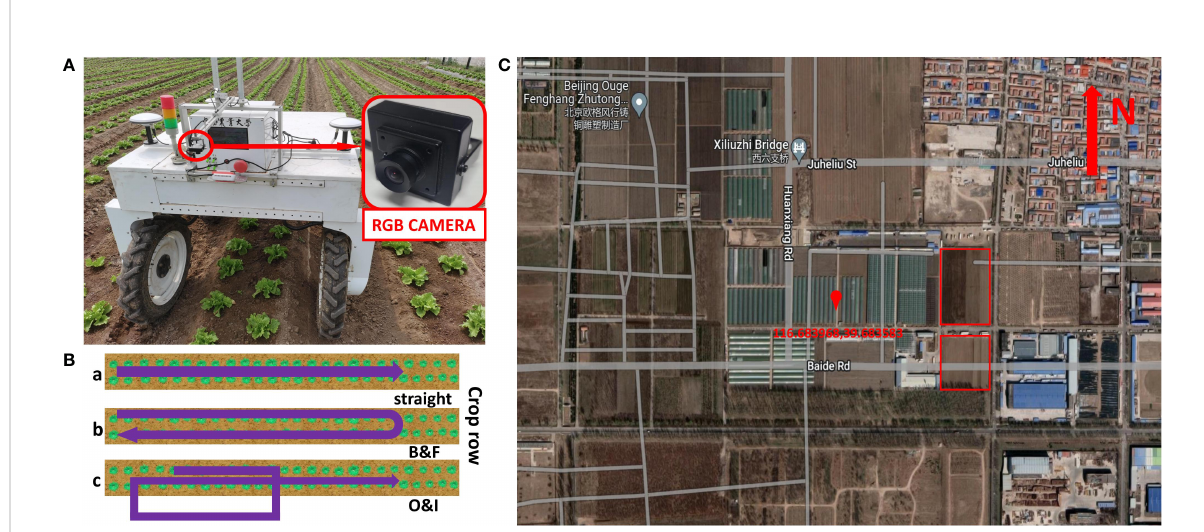
FIGURE 1 Details of data acquisition. (A) A RGB camera was installed in front of the VegeBot, an agricultural robot developed by China Agricultural University, and collected data in lettuce farm. (B) Three types of robot motions during image acquisition process. a, b and c correspond to straight, backward & forward, and turning out & turning in robot motions, respectively. (C) The location of the farm on satellite image. The red box is the place where the image is